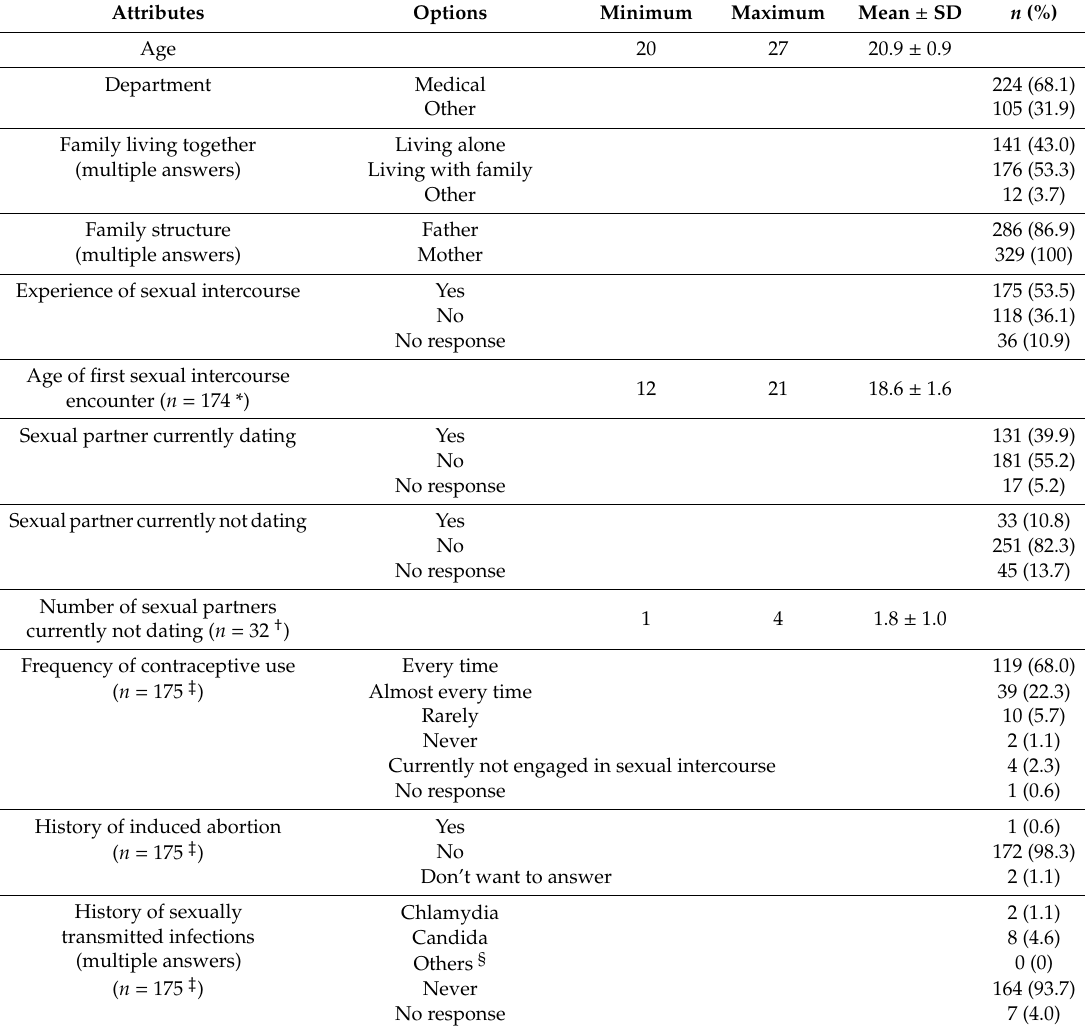
Table 1. Basic attributes ( n =